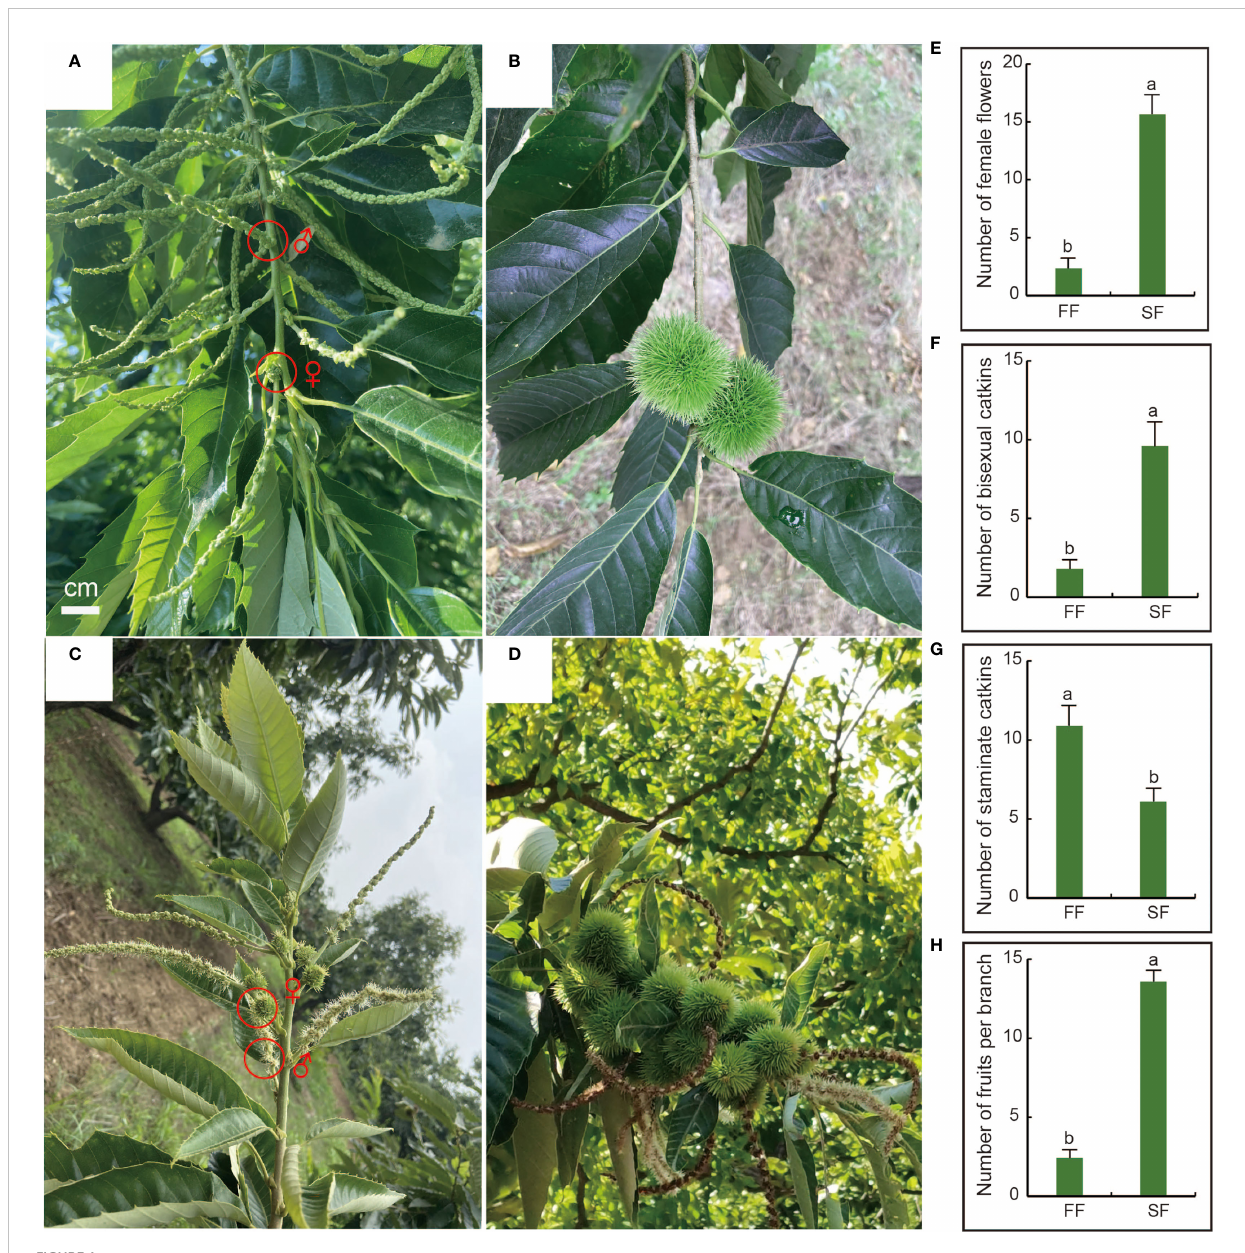
FIGURE 1 Differences in the number of male and female fl owers between fi rst and secondary fl owering of chestnut. (A) Chestnut fi rst fl ower morphology. The upper part of the branch bears a bisexual catkin, and the base of the bisexual catkin is a cluster of female fl owers. (B) 1 – 2 fruits growing in the upper part of the fi rst branch. (C) Secondary fl owering form of chestnut. Bisexual catkin can be borne from the base to the top of the branch. (D) Secondary branches can bear fruit in bunches on the branches. (E) The number of female secondary fl owers per fruiting branch is signi fi cantly higher than the number of female fi rst fl owers. (F) The number of bisexual in fl orescences per fruiting branch is signi fi cantly higher than that of fi rst fl owers. (G) The number of fi rst fl owering staminate catkins per fruiting branch was signi fi cantly higher than that of secondary fl owering. (H) The number of secondary fruits on each fruiting branch was signi fi cantly higher than that of fi rst fruits. Letters show signi fi cant differences at P < 0.05 based on a t-test; error bars represent